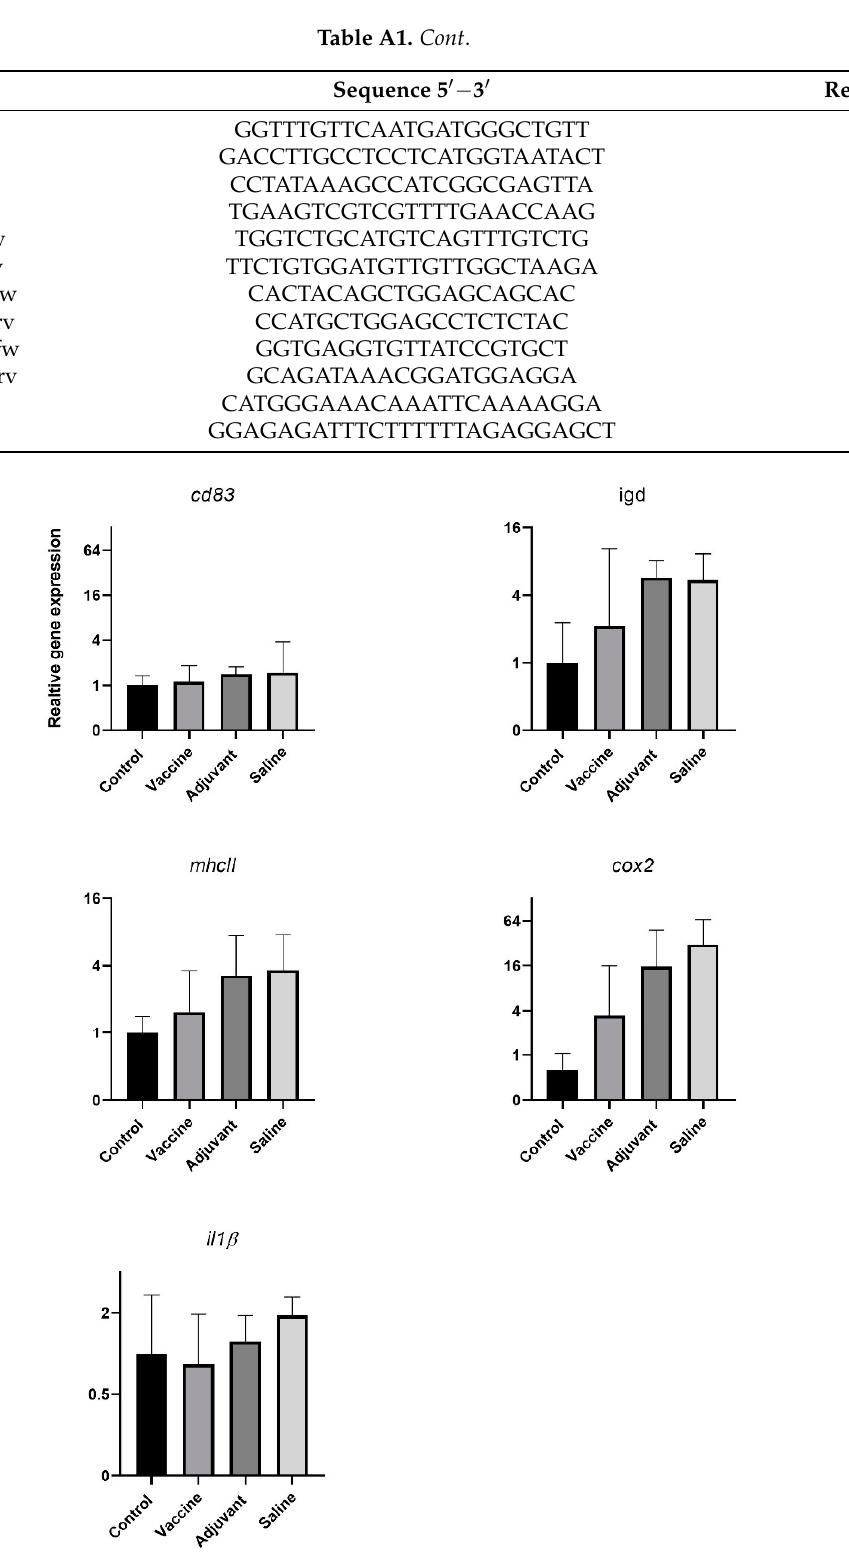
Figure A1. Immune genes with no significant differences in gene expression levels between the different treated groups during the vaccine trial in tilapia. Gene expression levels of the investigated genes were analyzed by qPCR and are displayed as log 2 of relative gene expression. The gene expression levels were tested for significant differences in between the treatments; ( p < 0.05; one-way ANOVA with multiple comparison using Tukey test; error bars indicate mean ±